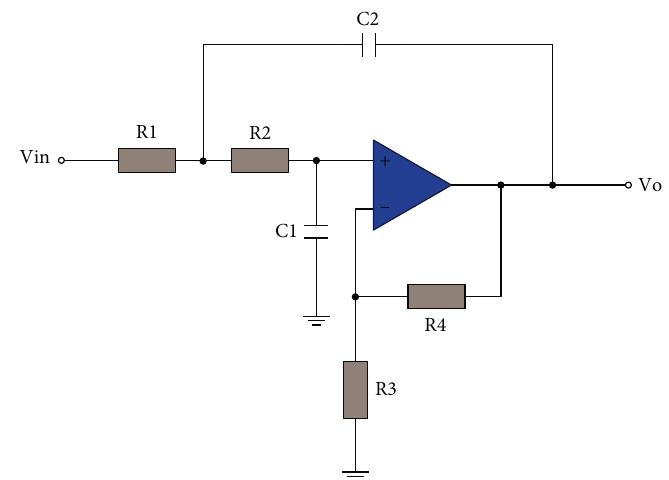
Figure 5: Circuit model of S–K